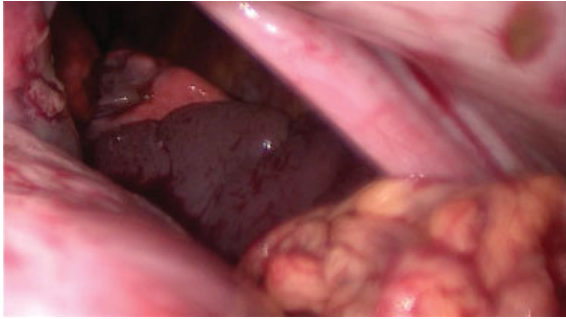
Fig. 4 Diagnostic laparoscopy: herniation of stomach, spleen, and bowel into the chest.